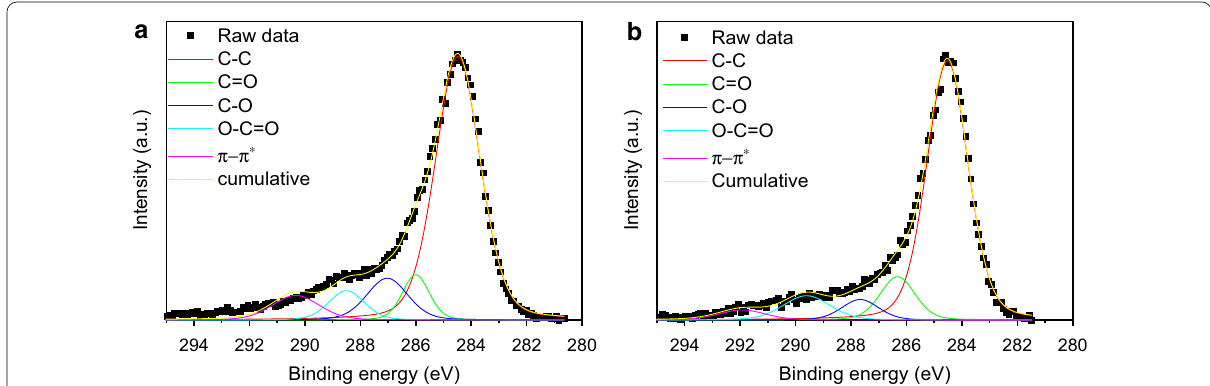
Fig. 3 XP spectra in the range of C 1 s of cCNTs ( a ) and cCNT‑SPIONs ( b ). The spectra are fitted with a combination of Gaussian and Lorentzian functions with the program